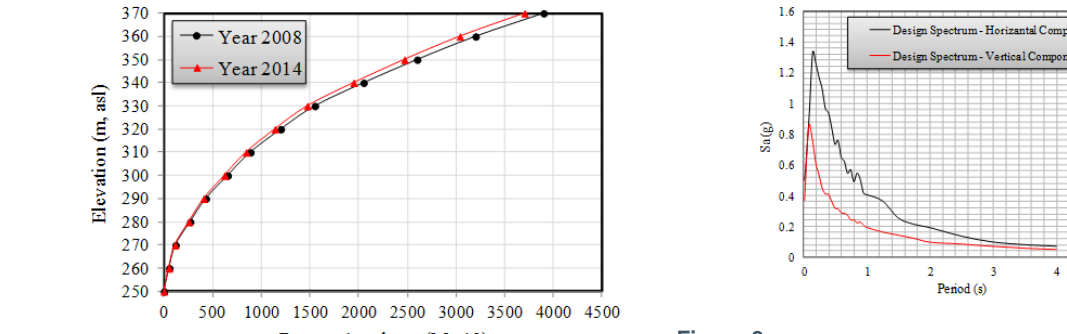
Figure 9. Design response spectrum for Dez dam site in maximum credible level